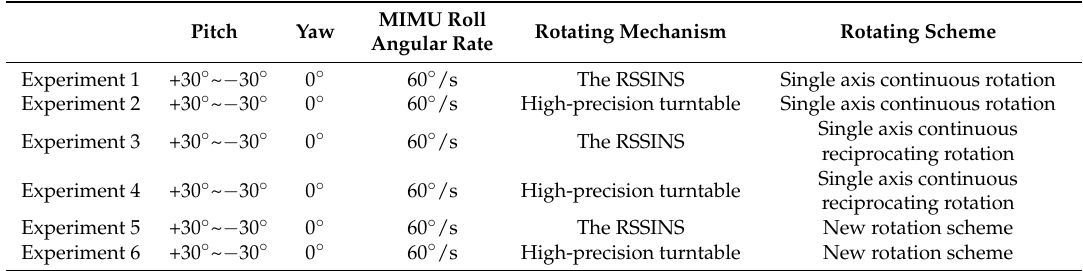
Table 4. Settings of the experiment conditions.